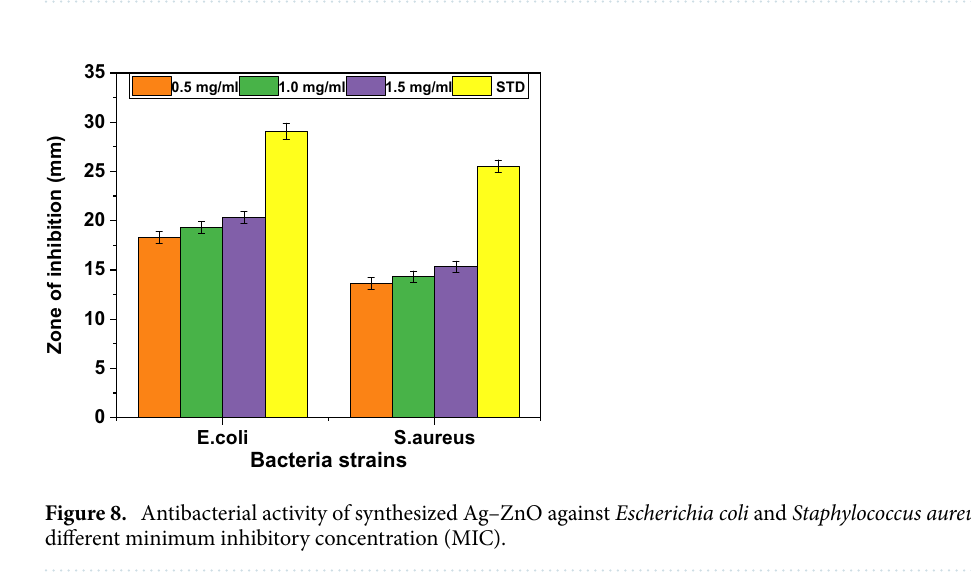
Figure 7. Zone of inhibition for pure ZnO and Ag–ZnO nanocomposite with different Ag content at different synthetic temperature for ( a ) Escherichia coli ( b ) Staphylococcus aureus and minimum inhibitory concentration (MIC) values for pure ZnO and Ag doped ZnO for ( c ) Escherichia coli ( d ) Staphylococcus aureus .